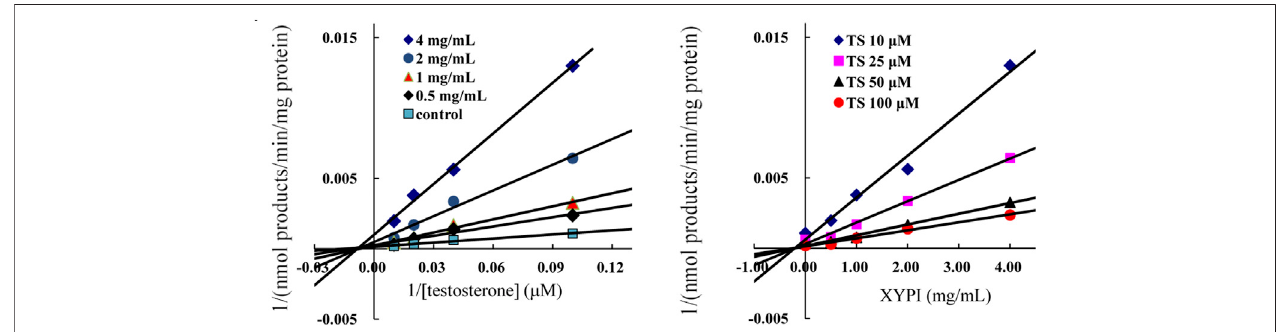
FIGURE 4 | Representative Lineweaver-Burk plots (A) and Dixon plots (B) of XYPI on CYP3A4-mediated testosterone 6 β -hydroxylation metabolism. Each point represents mean ± SD (n (cid:1) 3).